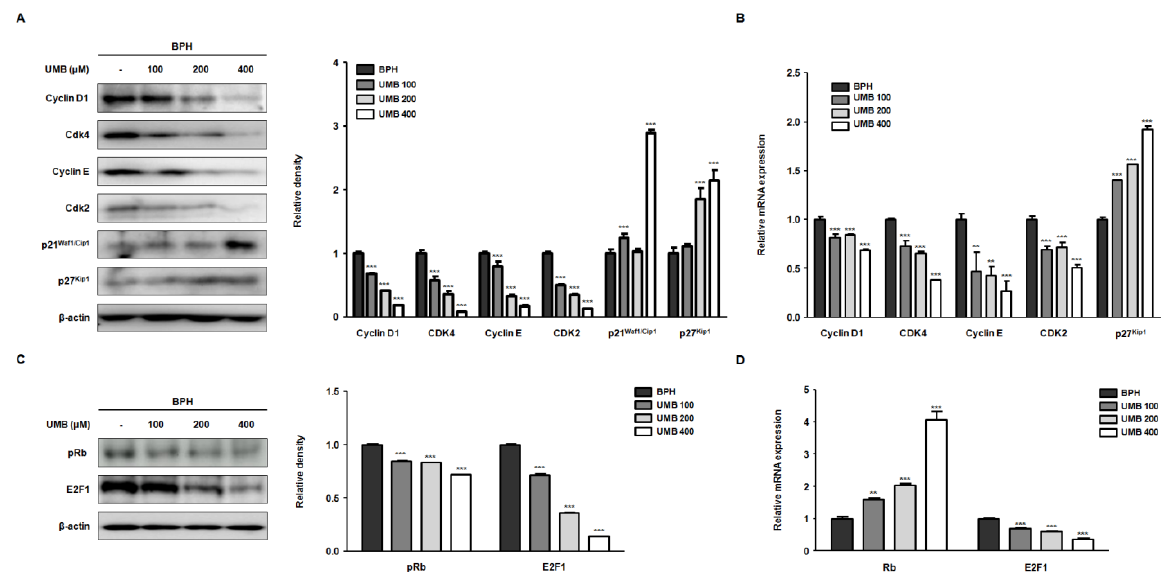
Figure 2. Effect of UMB on cell cycle arrest at the G1/S phase in BPH-1 cells. ( A – D ) BPH-1 cells were treated with or without 100, 200, and 400 μ M of UMB. The protein expression of ( A ) cyclin D1, Cdk4, cyclin E, Cdk2, p21 Waf1/Cip1 , p27 Kip1 , ( C ) pRb and E2F1 was determined by Western blot analysis using specific antibodies. The relative density of the protein was normalized to that of β -actin, which was used as an internal control. The mRNA expression of ( B ) cyclin D1, Cdk4, cyclin E, Cdk2, p27 Kip1 , ( D ) Rb, and E2F1 was quantified using qRT-PCR in BPH-1 cells. The relative mRNA expression was normalized using the Ct value of β -actin. The values represent as mean ± S.D. of three independent experiments. ** p < 0.01, *** p < 0.001 vs. vehicle control.